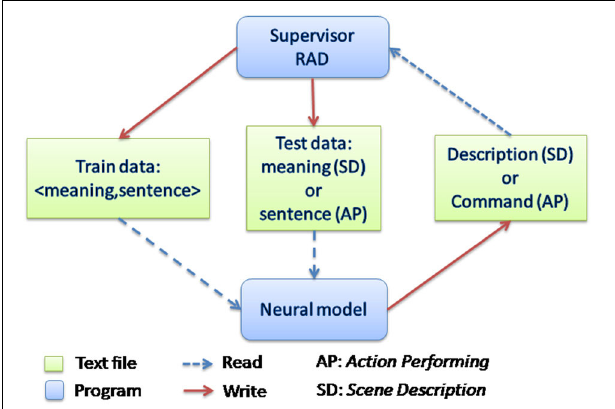
FIGURE 5 | Communication between modules. The Supervisor manages the spoken interaction with the user and controls the robotic platform, providing different behaviors in SD and AP tasks. Depending on the mode selected by the user, train or test, it launches the neural model or not. In the train mode, pairs of < meaning, sentence > are stored in the train data file. In test mode, the sentence to be tested is written in the test data file, and both train and test files are sent at once to the Neural model. See Figure 2 for complementary